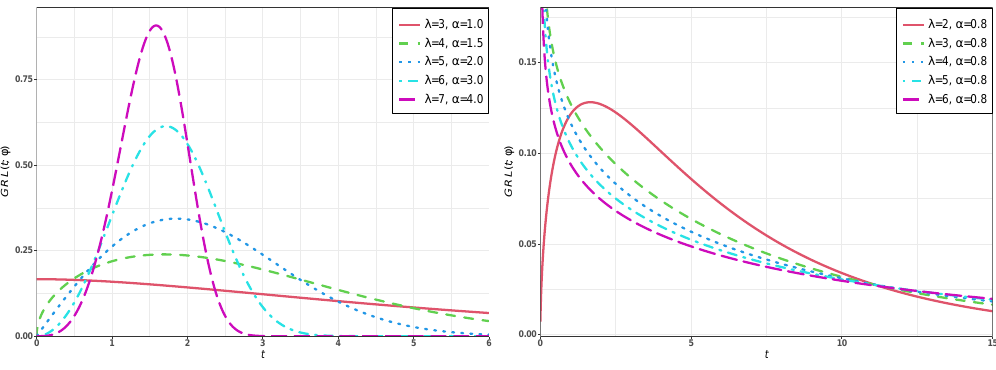
Figure 2. PDF shapes for the GRL distribution considering different values of λ and α